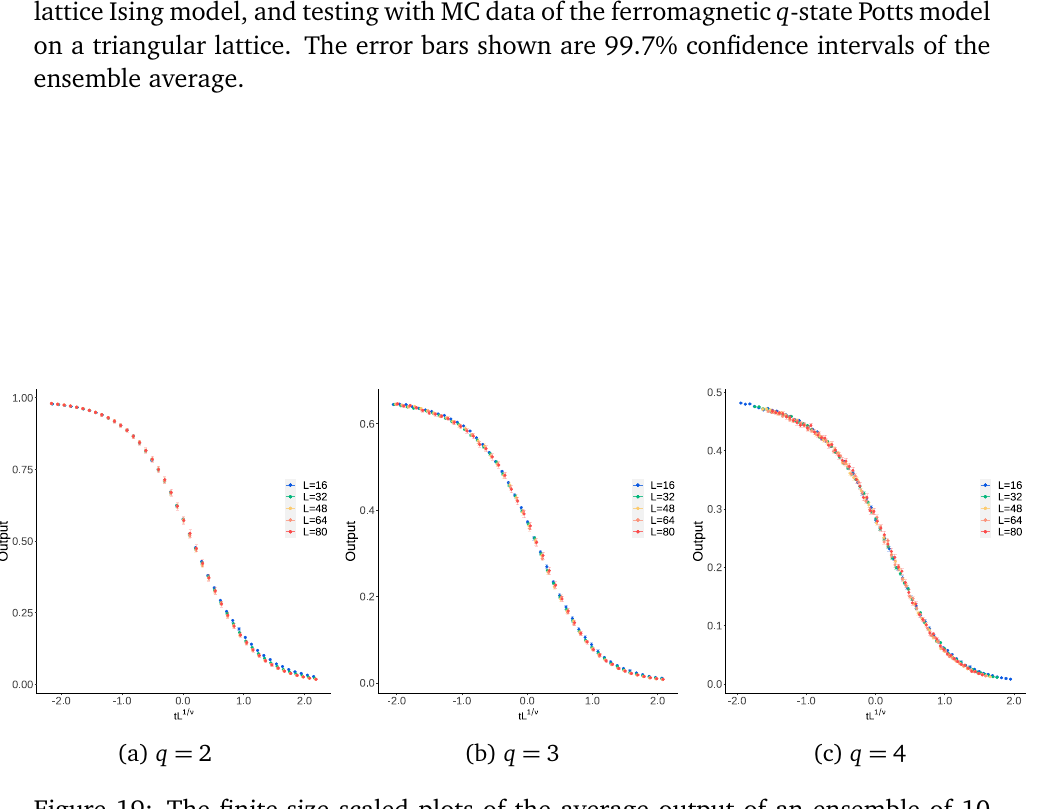
Figure 19: The finite-size scaled plots of the average output of an ensemble of 10 independently trained ANNs – training with MC data of the ferromagnetic square- lattice Ising model, and testing with MC data of the ferromagnetic q -state Potts model on a honeycomb lattice. The error bars shown are 99.7% confidence intervals of the ensemble